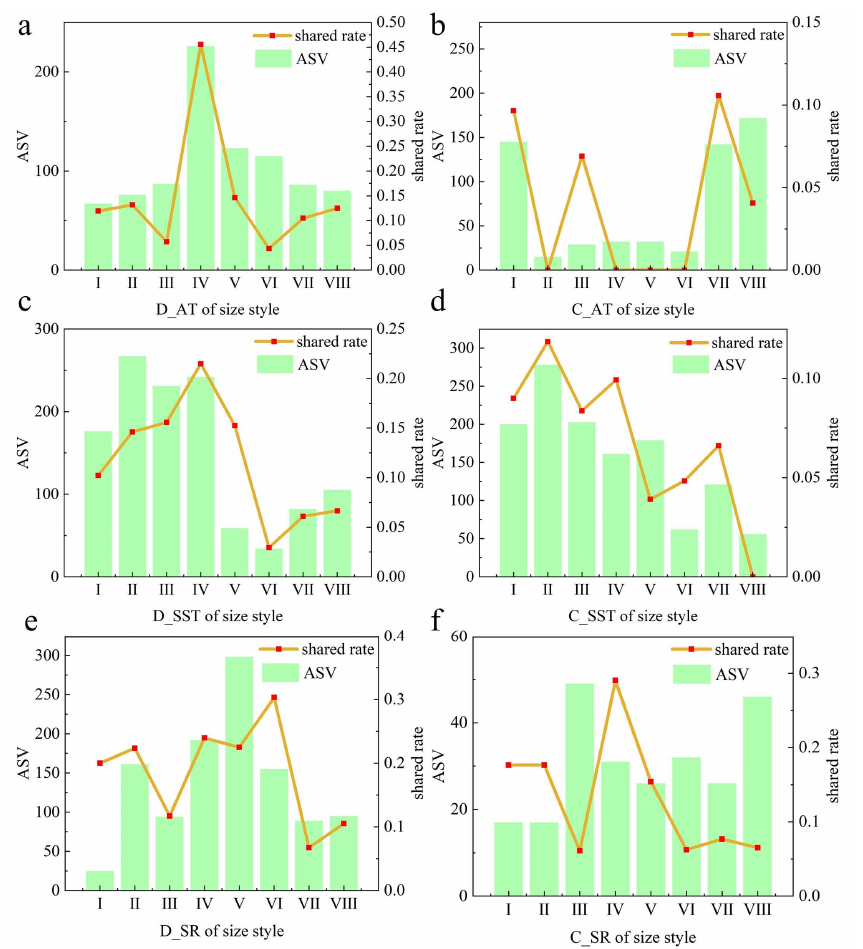
Figure 5. ASV in size distribution and shared rate of ASVs from aerosol and wastewater. ( a ) D_AT (aeration tank of Plant D), ( b ) C_AT (aeration tank of Plant C), ( c ) D_SST (secondary settling tank of Plant D), ( d ) C_SST (secondary settling tank of Plant C), ( e ) D_SR (screen room of Plant D), ( f ) C_SR (screen room of Plant C). Ⅰ – Ⅷ: from the first to the eighth particle-size stages.